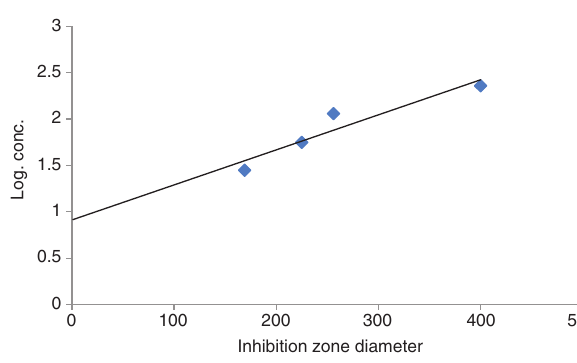
Figure 3: Particle size distribution of AgNeemnano.